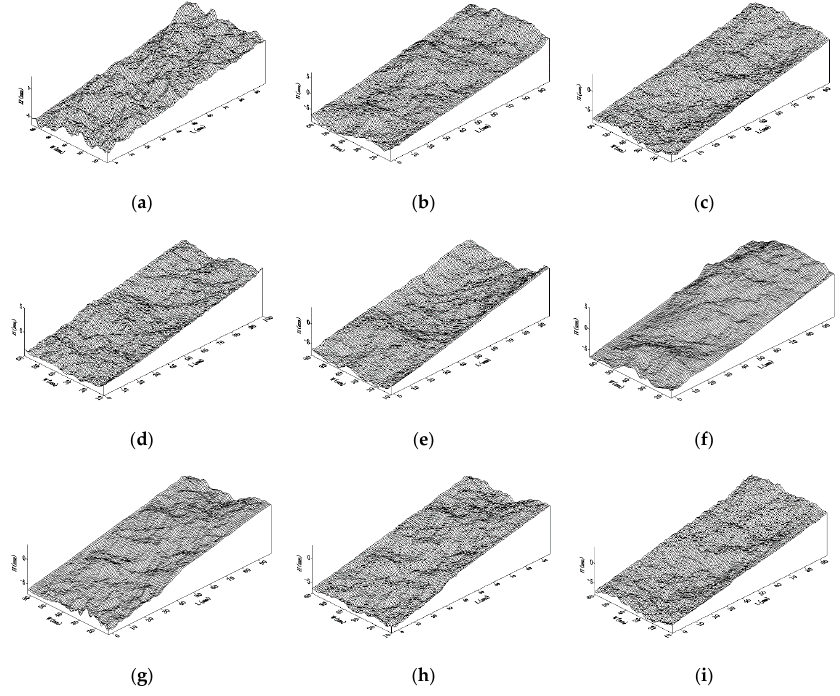
Figure 3. 3D surface profiles of fracture surfaces of the nine samples, ( a – i ) respectively corresponding to #Fr1 – #Fr9, (all dimensions are in units of mm). to #Fr1–#Fr9, (all dimensions are in units of